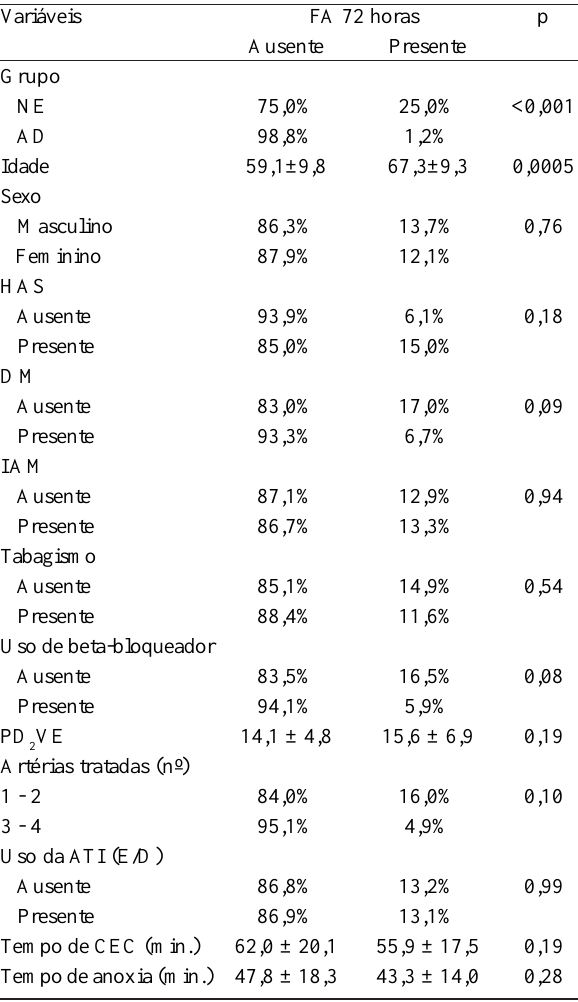
FA = fibrilação atrial; NE = grupo não estimulado; AD = grupo submetido a estimulação atrial direita; HAS = Hipertensão Arterial Sistêmica; DM = Diabetes Mellitus; IAM = Infarto Agudo do Miocárdio; PD2VE = pressão diastólica final do ventrículo esquerdo; ATI = artéria torácica interna; CEC = circulação